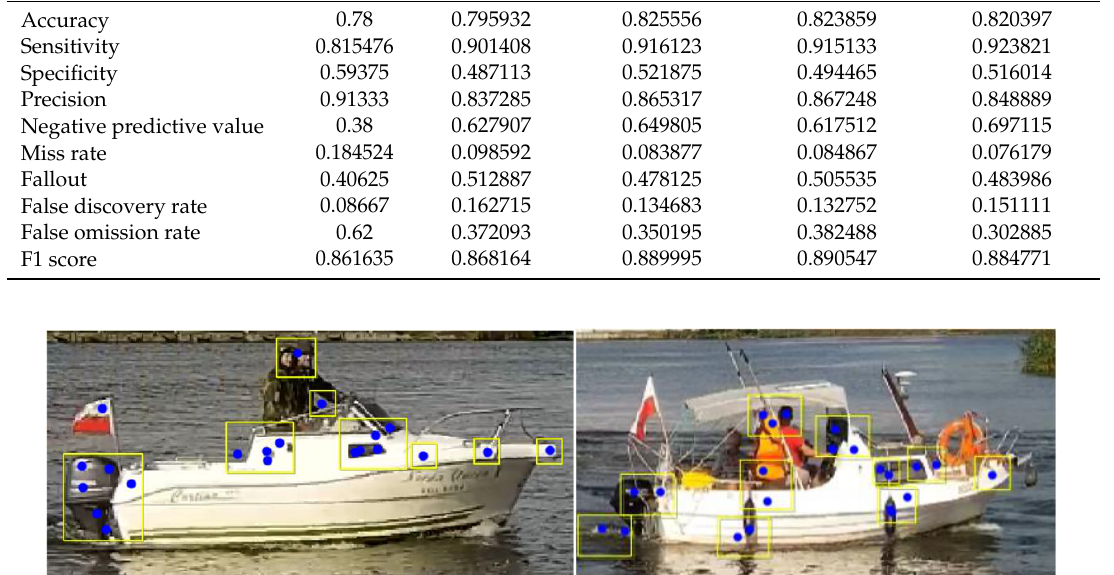
Figure 2. Examples of clustered keypoints for motorboat images. Table 3. Statistical coefficients for classification measurements using the selected keypoint search algorithm with Euclidean metric and CNN.